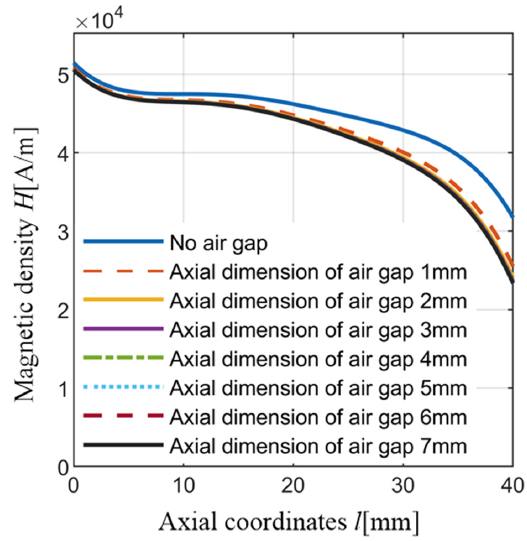
Figure 16. The axial magnetic density distribution of the GMM cylinder by changing the air gap size.